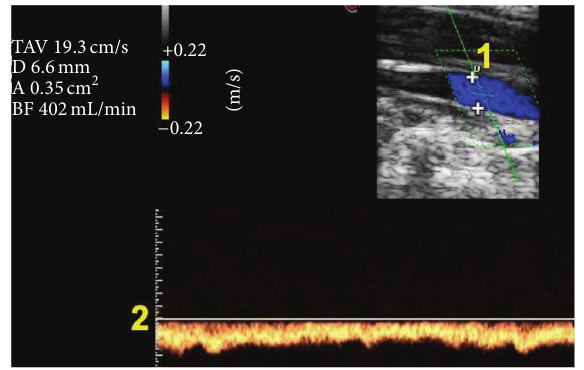
Figure 1: Current ECD assessment of flow rate in the internal jugular vein. The flow is automatically calculated by the product of the diameter (1) with the TAV (2). In this case, the TAV, visible on the left upper side of the figure, is 19.3 cm/sec. The diameter (D) is 6.6 mm. With the arbitrary assumption of the circular shape of the vein, the area of the vein (A) is 0.35 cm 2 . Consequently the flow rate is 402